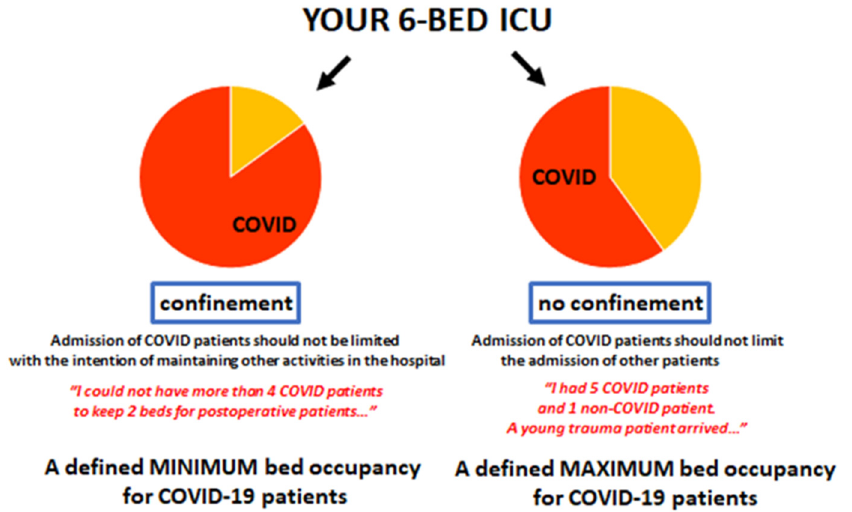
Figure 1. Two phases of reserving ICU beds for COVID-19 patients.